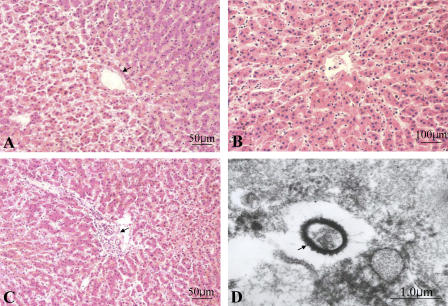
Microscopic Characterization of Sectioned Liver Tissue from Patients Who Had Died(A) Light image of a liver tissue section (×100). The central vein is indicated with an arrow.(B) Light image of a liver tissue section (×200).(C) The convergent zone is indicated with an arrow (×100).(D) TEM image of a liver tissue section (×20,000). A bacterium found in the tissue is highlighted with an arrow.